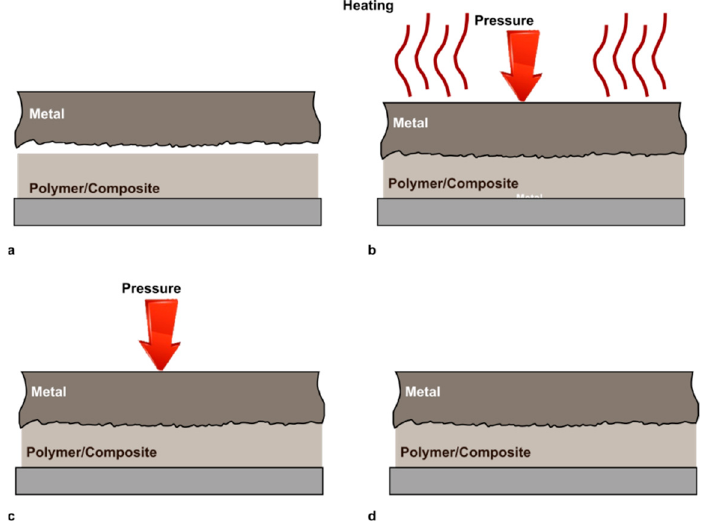
Figure 14. Schematic of a thermomechanical joining process: ( a ) Positioning; ( b ) Heating and pressing; ( c ) Consolidation; and ( d ) Finished joint.